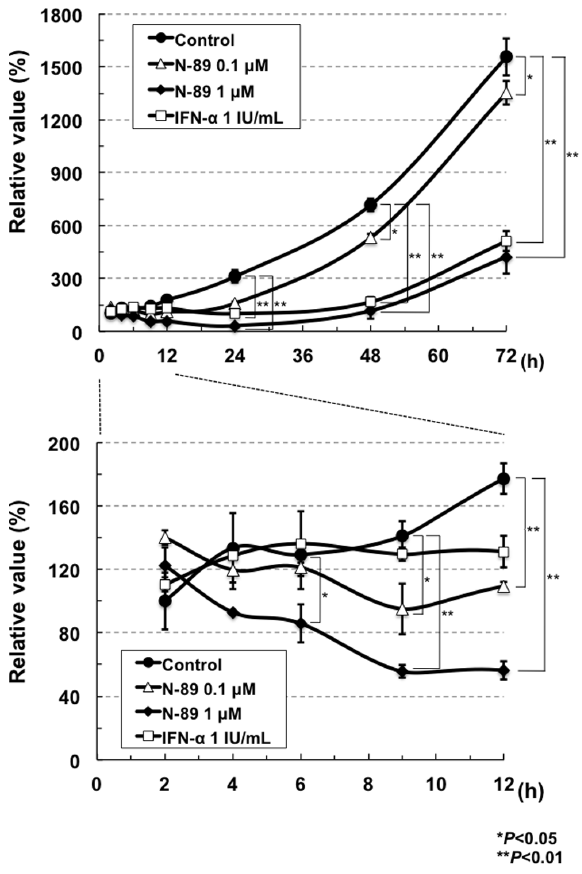
Figure 4. The anti-HCV action of N-89 was faster than that of IFN- a . The ORL8 cells were treated with N-89 or IFN- a , and then RL assays were performed at 2 to 72 hrs after the treatment. The relative value (%) calculated at each time point, when the luciferase activity of non-treated cells at 24 hrs was assigned as 100%, is shown. Data are expressed as the means 6 standard deviation of triplicate assays. The data within 12 hrs after the treatment are shown in the lower panel. * P , 0.05; ** P , 0.01. The Anti -HCV Activities of N-89 and N-251 were Completely Canceled by VE We previously reported that the antioxi- dant VE canceled the anti-HCV activities of CsA and three nutrients ( b - carotene, vitamin D 2 , and linoleic acid) [37], and demonstrated that the oxidative stress induced by these anti-HCV reagents caused anti-HCV status via activation of the extracellular signal-regulated kinase signaling pathway [38]. To evaluate this possibility, we examined the effect of VE on N-89 at the EC 90 level in the ORL8 assay. CsA and IFN- a were also used as a positive and a negative control, respectively, on the effect of VE in the ORL8 assay. The results revealed that the anti-HCV activities of N-89 and CsA were largely canceled by VE, whereas the activity of IFN- a was not canceled (Fig. 5A). We normalized these results by dividing the RL value obtained in the presence of VE by that in the absence of VE as described previously [22,37]. The values of N-89 and CsA were 16 and 34, respectively, whereas the value (3.2) of IFN- a was almost the same as that (3.0) of the control (Fig. 5B). Similar results were obtained by using N-251 (Fig. 5C and D). The values of N-251, CsA, and IFN- a were 13, 19, and 4.3, respectively, in comparison with the value (2.3) of the control (Fig. 5D). These results suggest that the induction of oxidative stress is associated with the anti-HCV activity of N-89 or N-251. However, an antimalarial drug, artemisinin, was hardly influenced by co- treatment with VE (Fig. 5E). The value (1.9) of artemisinin was almost the same as that (3.5 or 2.5) of IFN- a or the control, respectively (Fig. 5F). These results were also confirmed by Western blot analysis of HCV Core (Fig. 5G). Therefore, our results suggest that the anti-HCV mechanism of artemisinin is not associated with the induction of oxidative stress, and is distinct from that of N-89 or